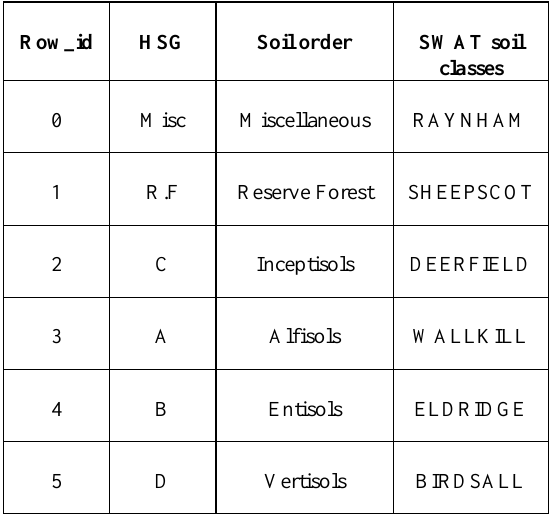
Figure 5. SWAT Soil classes